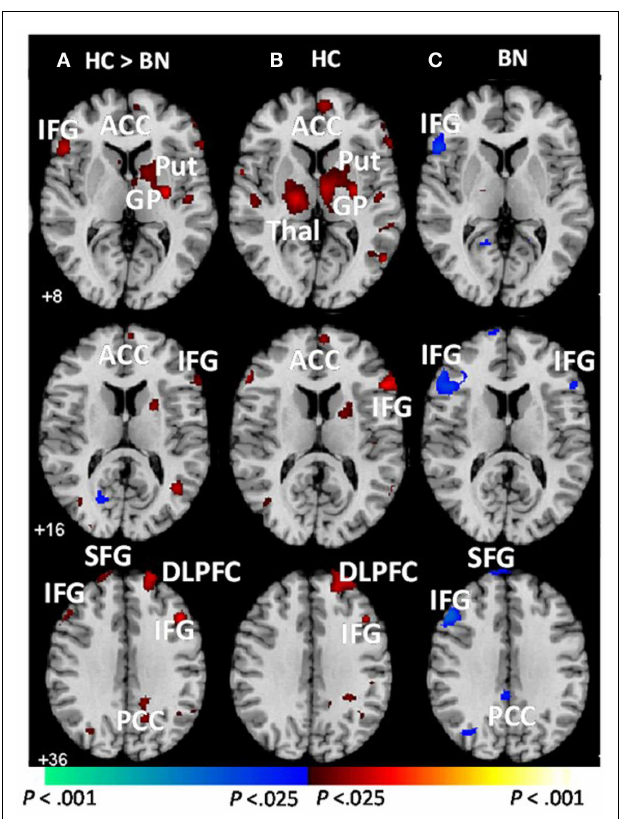
FIGURE 1 | Group average brain activations during correct trials [adapted from Marsh et al. (2011)] .These are axial slices positioned inferiorly to superiorly (top to bottom). (A) Group-by-stimulus (congruent vs. incongruent) interactions were detected in frontostriatal regions (red). Main effects of stimulus condition (congruent vs. incongruent) are shown for the (B) healthy control and (C) BN adolescents . Increases in signal during correct incongruent relative to correct congruent trials are shown in red, and decreases are shown in blue. BN, bulimia nervosa; HC, healthy control; ACC, anterior cingulate cortex; DLPFC, dorsolateral prefrontal cortex; HI, hippocampus; IFG, inferior frontal gyrus; Put, putamen; GP, globus pallidus; Thal, thalamus; SFG, superior frontal gyrus; PCC, posterior cingulate cortex; MFG, medial frontal gyrus. Adapted and reprinted with permission from American Psychiatric